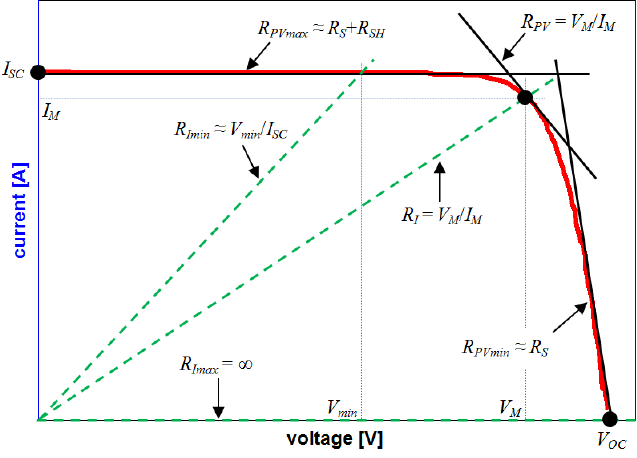
Figure 12. Determining open-loop instability